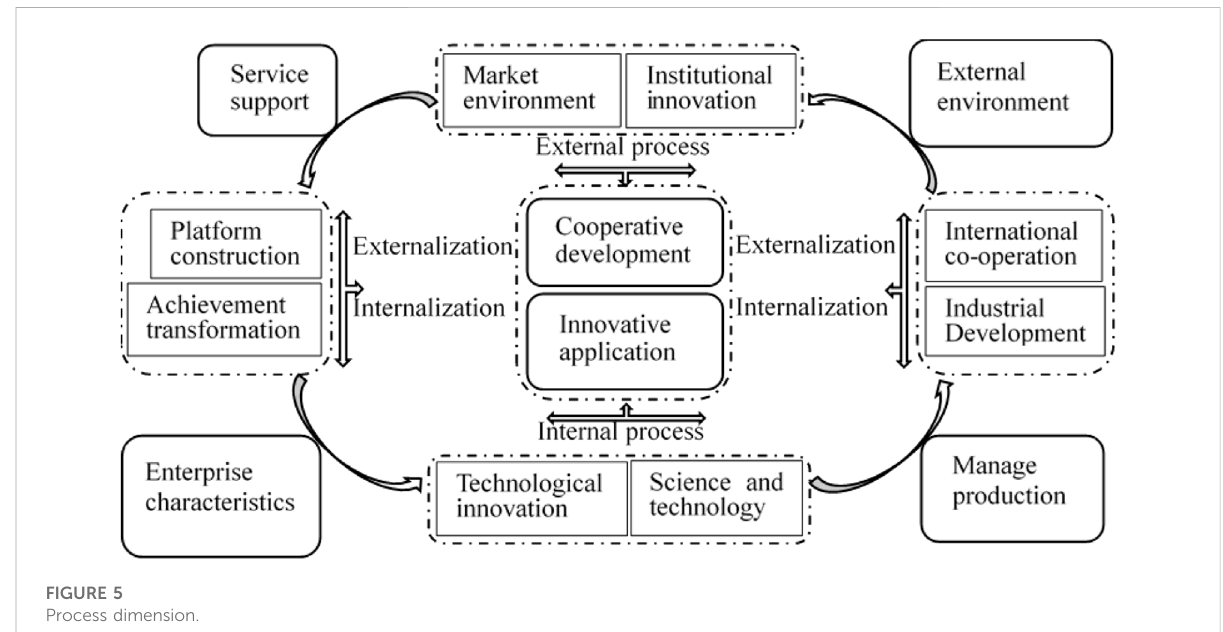
FIGURE 5 Process